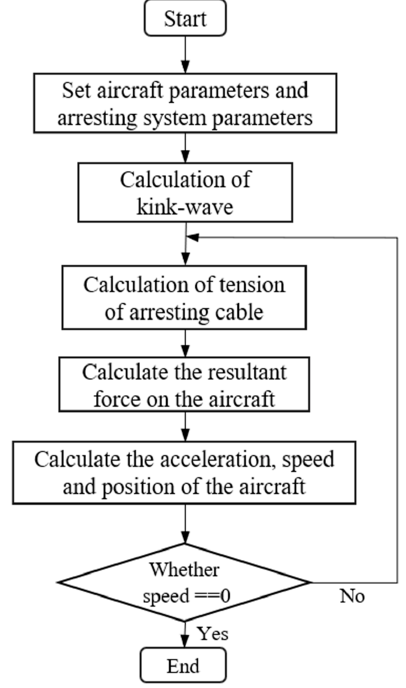
Figure 7. Diagram of calculation chart.